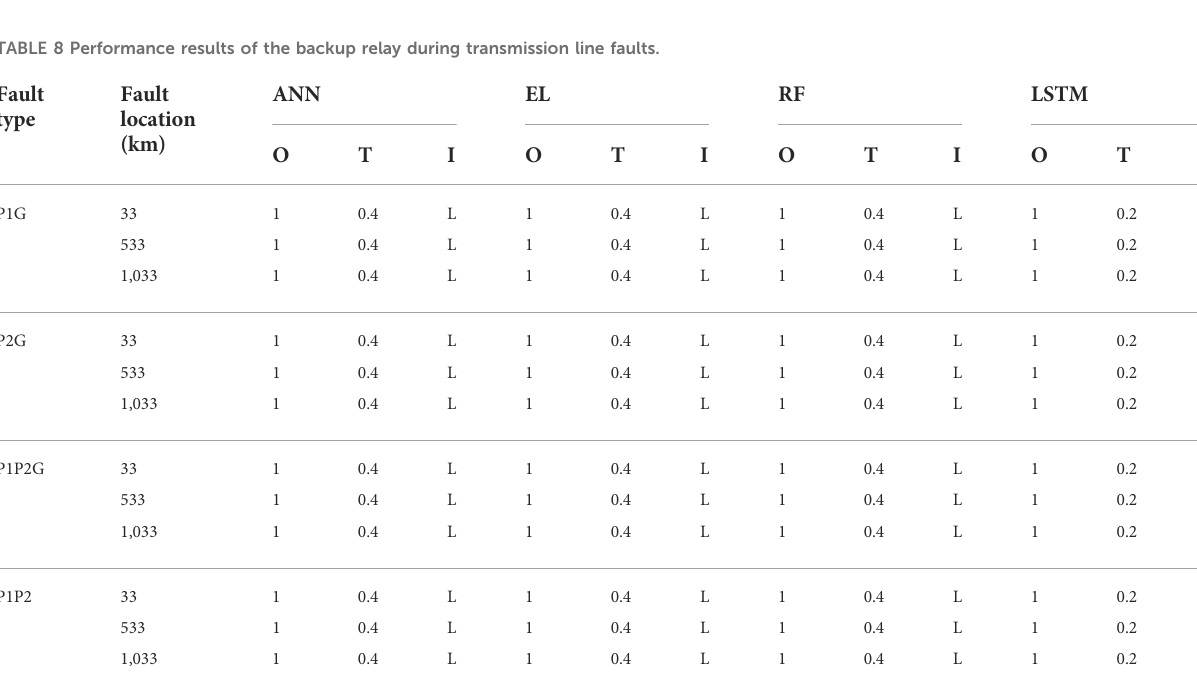
output for all four methods. Results show that all methods identify the fault pole accurately, but the LSTM method takes less time compared to other methods.